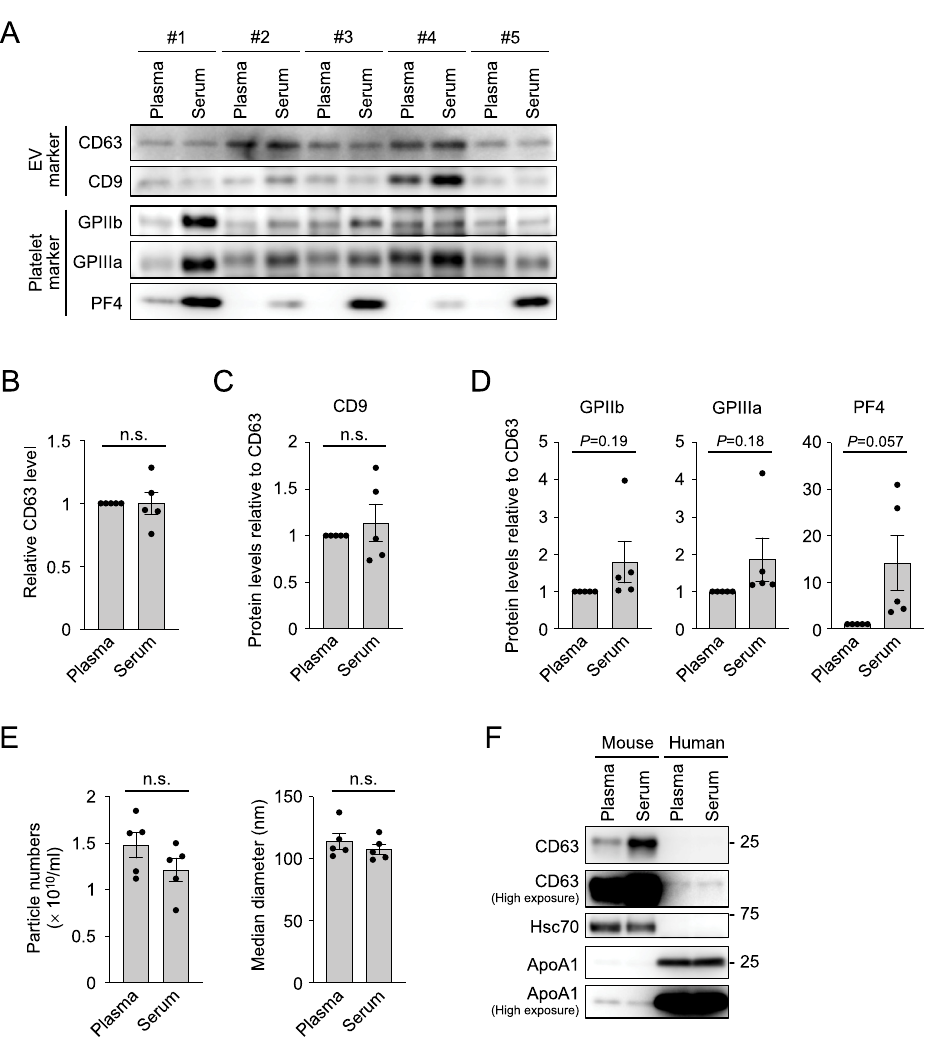
Fig 5. Serum EVs contain high levels of platelet proteins in human blood. (A) Western blot analysis of the sEV fractions derived from plasma and serum of 5 individuals, using antibodies against EV markers and platelet-specific proteins. Equal amounts of proteins were loaded onto each lane and analyzed. (B) Bar graph showing relative protein levels of CD63 that were calculated from the band intensity of the Western blot image in (A). (C-D) Bar graphs showing the levels of the EV marker CD9 (C), and platelet-specific markers GPIIb, GPIIIa and PF4 (D), relative to that of CD63. Whereas the level of CD9 was comparable between the sEV fractions from plasma and serum, all the platelet markers showed a clear tendency of increased levels in serum EVs. (E) NTA results showing the numbers (left) and median diameters (right) of the particles in the sEV fractions derived from human plasma and serum. (F) Comparison of the sEV fractions derived from mouse and human blood by Western blot analysis using antibodies against EV markers and lipoprotein ApoA1. The sEV fractions isolated from human blood contain very low levels of the EV markers CD63 and Hsc70, but a high level of ApoA1, implying a large difference in particle population between human and mouse blood. Data are shown as the average ± SEM. Student t -test. n.s., not